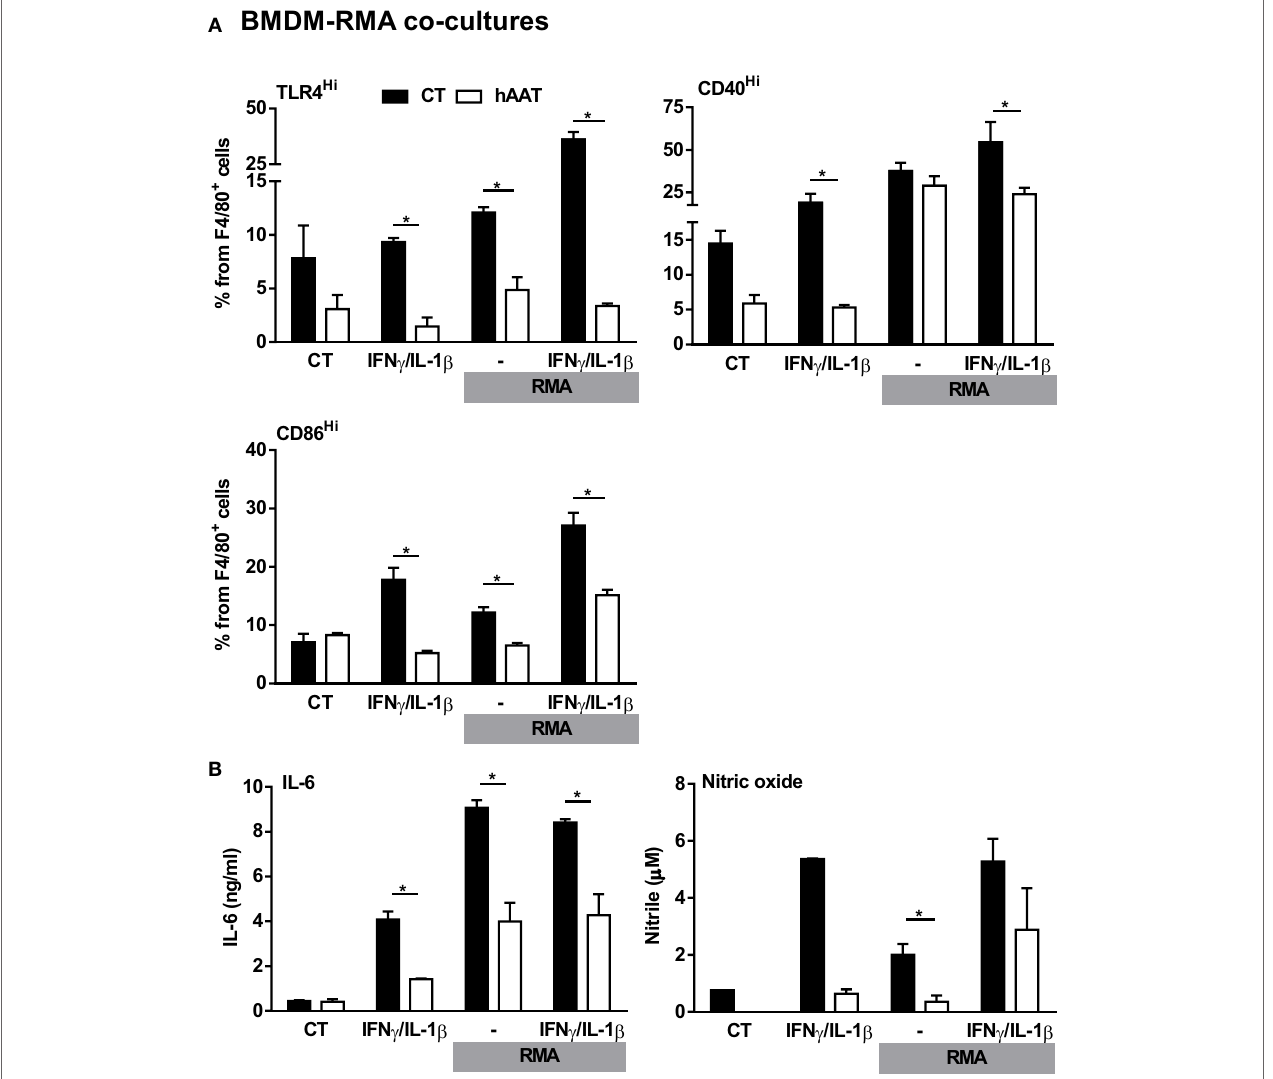
FigUre 6 | Unmodified haaT exerts anti-inflammatory effect on BMDM–rMa cocultures . BMDMs (1 × 10 6 cells per well in triplicate) were pretreated with hAAT (0.5 mg/ml); after 24 h BMDMs were cocultured with RMA cells (2.5 × 10 5 cells per well) with or without stimulation with IFN γ and IL-1 β (both at 10 ng/ml). RMA cells were diluted 1:4 after 48 h, and after 72 h (a) cells were washed and stained for flow cytometric analysis, and (B) supernatants were examined for IL-6 and NO levels. Mean ± SEM, * p < 0.05. Unpaired two-tailed Student’s t -test was employed to assess differences between